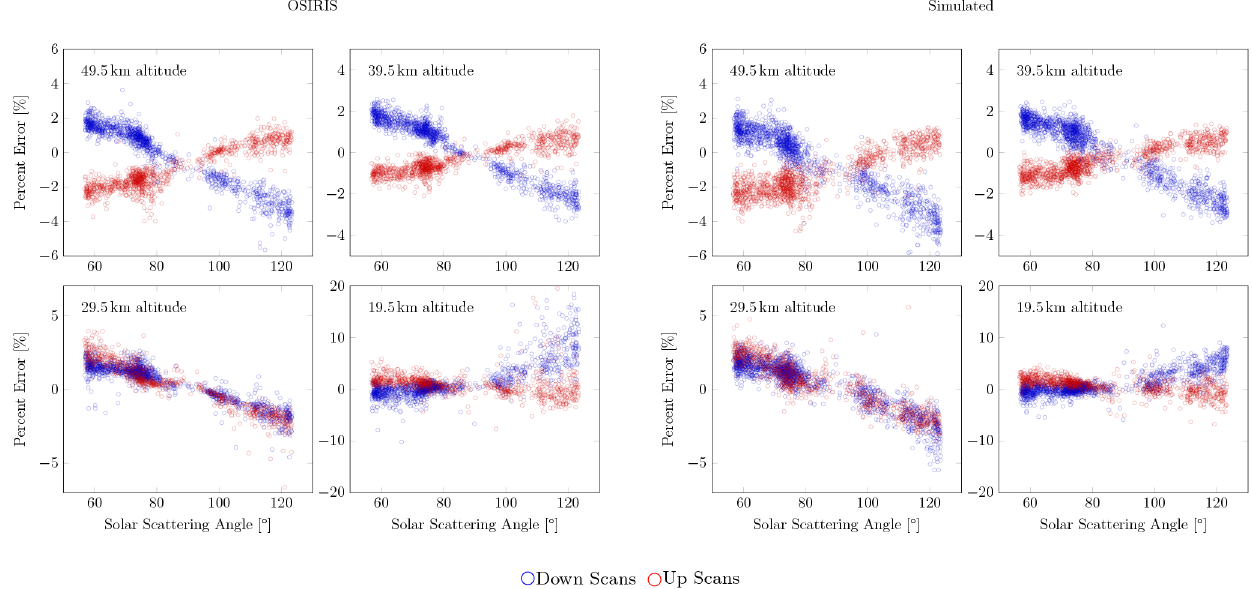
Figure 8. Percent difference between retrieved ozone number density when the forward model is run with one diffuse profile compared to five, i.e. ( [ O 3 ] ( 1 ) −[ O 3 ] ( 5 ) )/ [ O 3 ] ( 5 ) · 100%, as a function of solar scattering angle at select altitudes. Red and blue circles correspond to when the instrument is scanning upward and downward respectively. The left panel shows the results when retrieving from OSIRIS measurements, while the right panel is the results when retrieving from MC-simulated measurements.